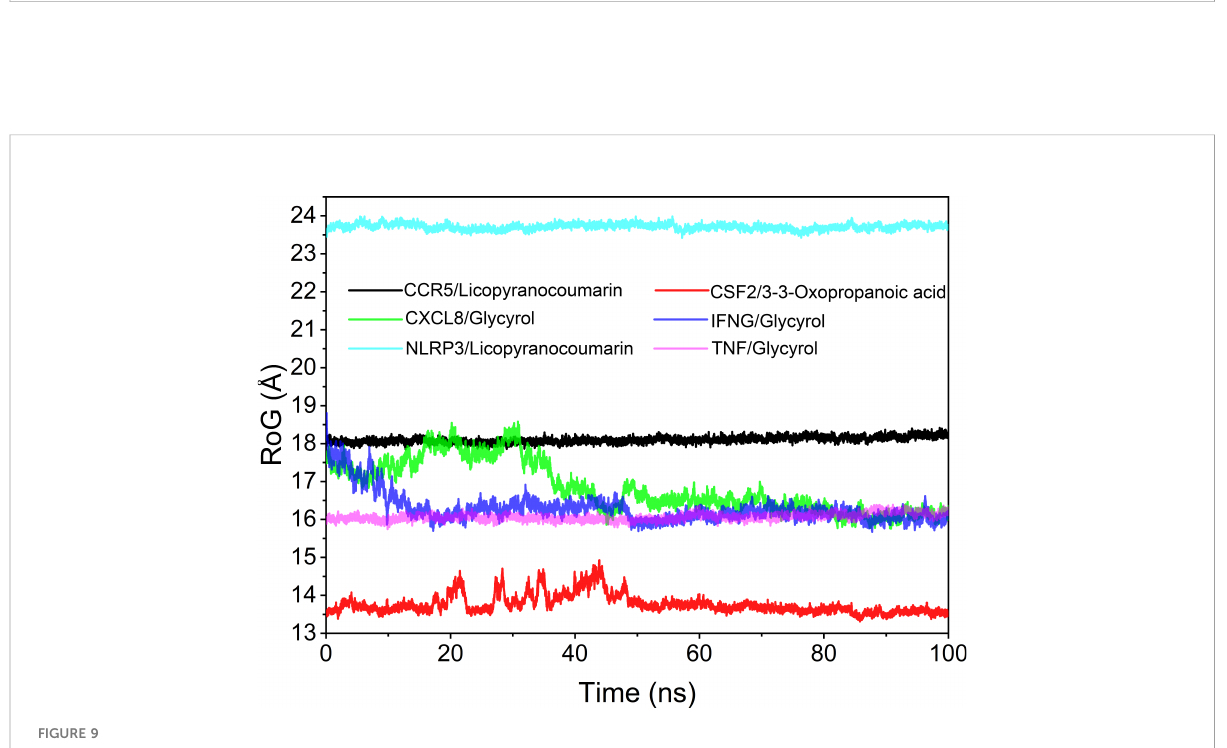
FIGURE 9 Analysis of radius of rotation